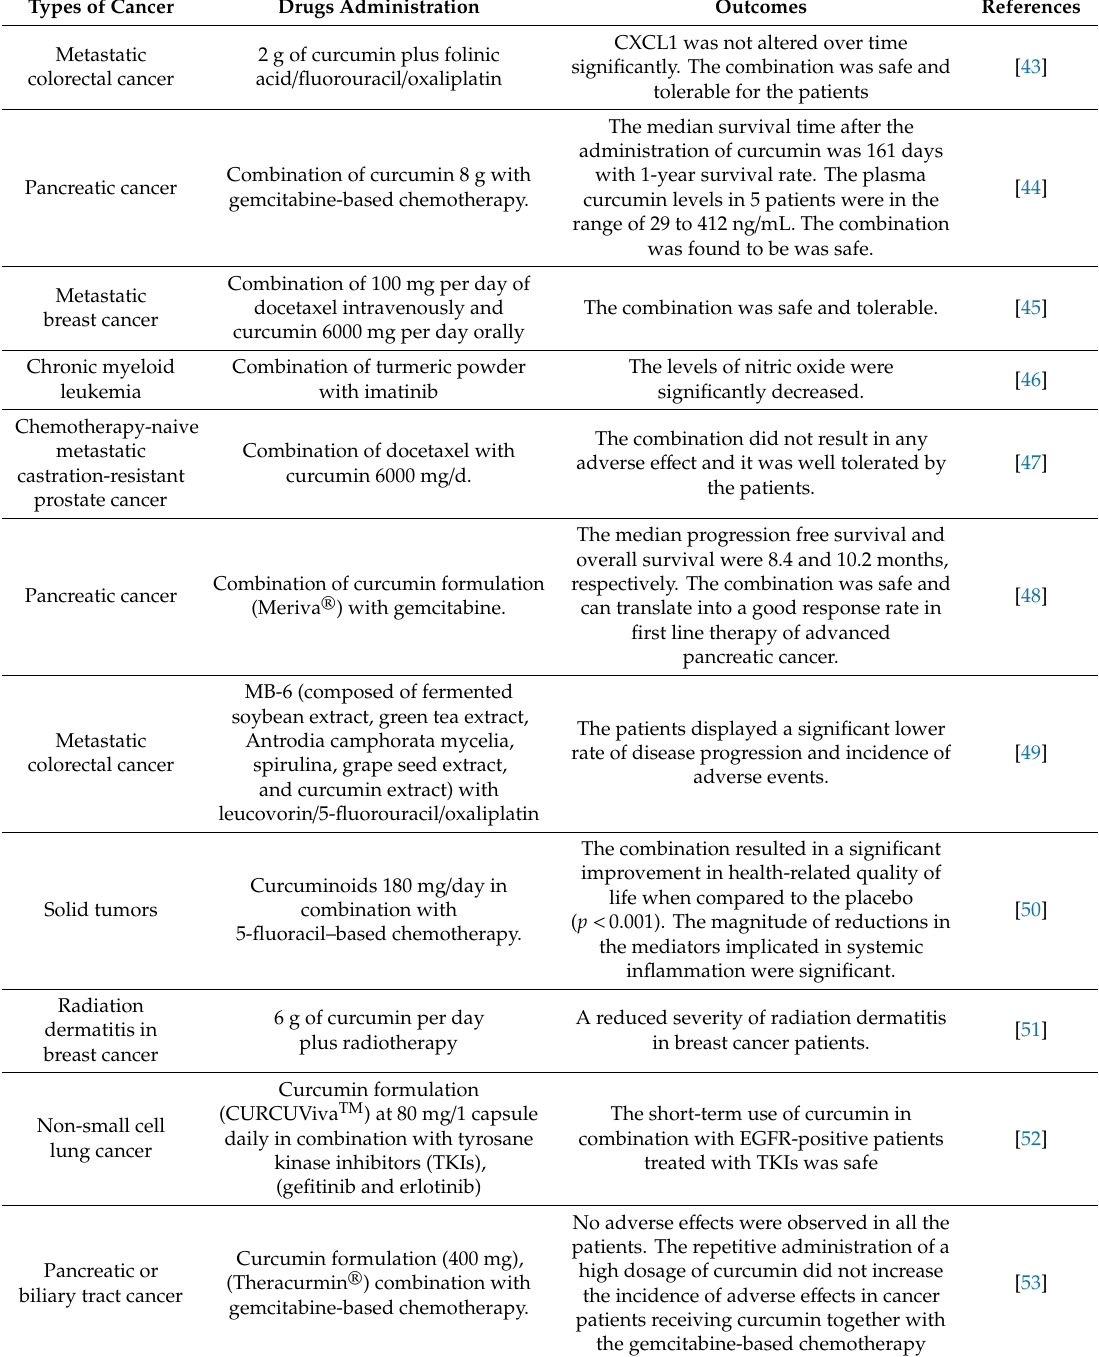
Table 1. E ffi cacy of curcumin in clinical